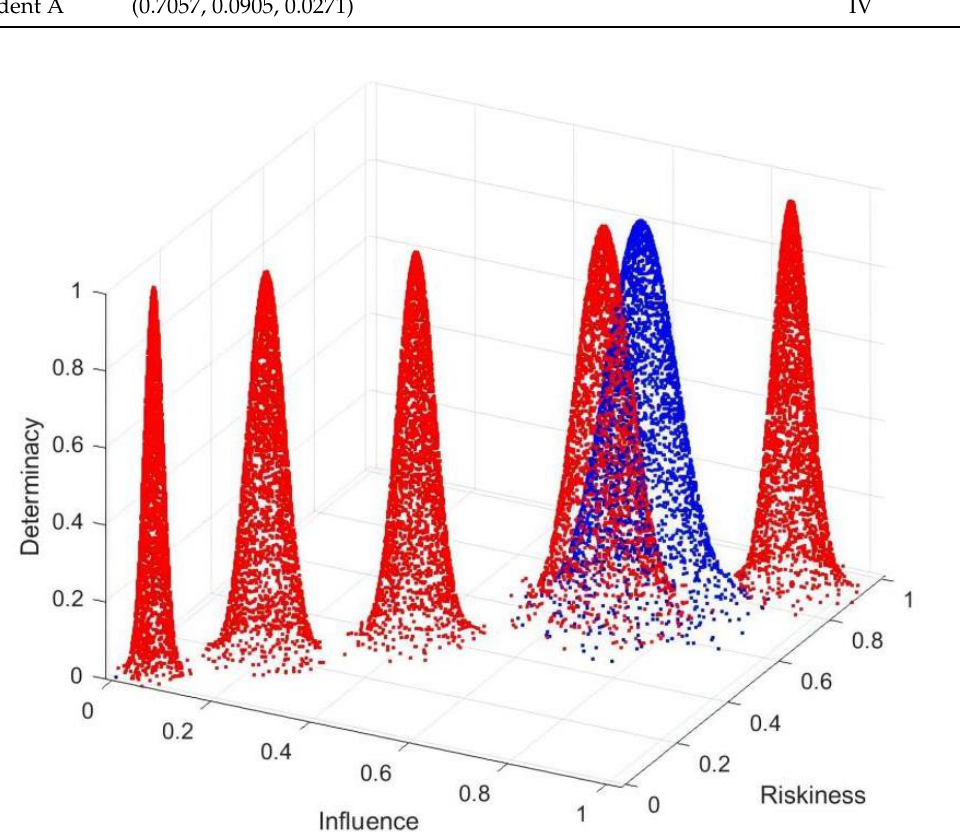
Figure 11. Integrated cloud model for LNG leakage accident.